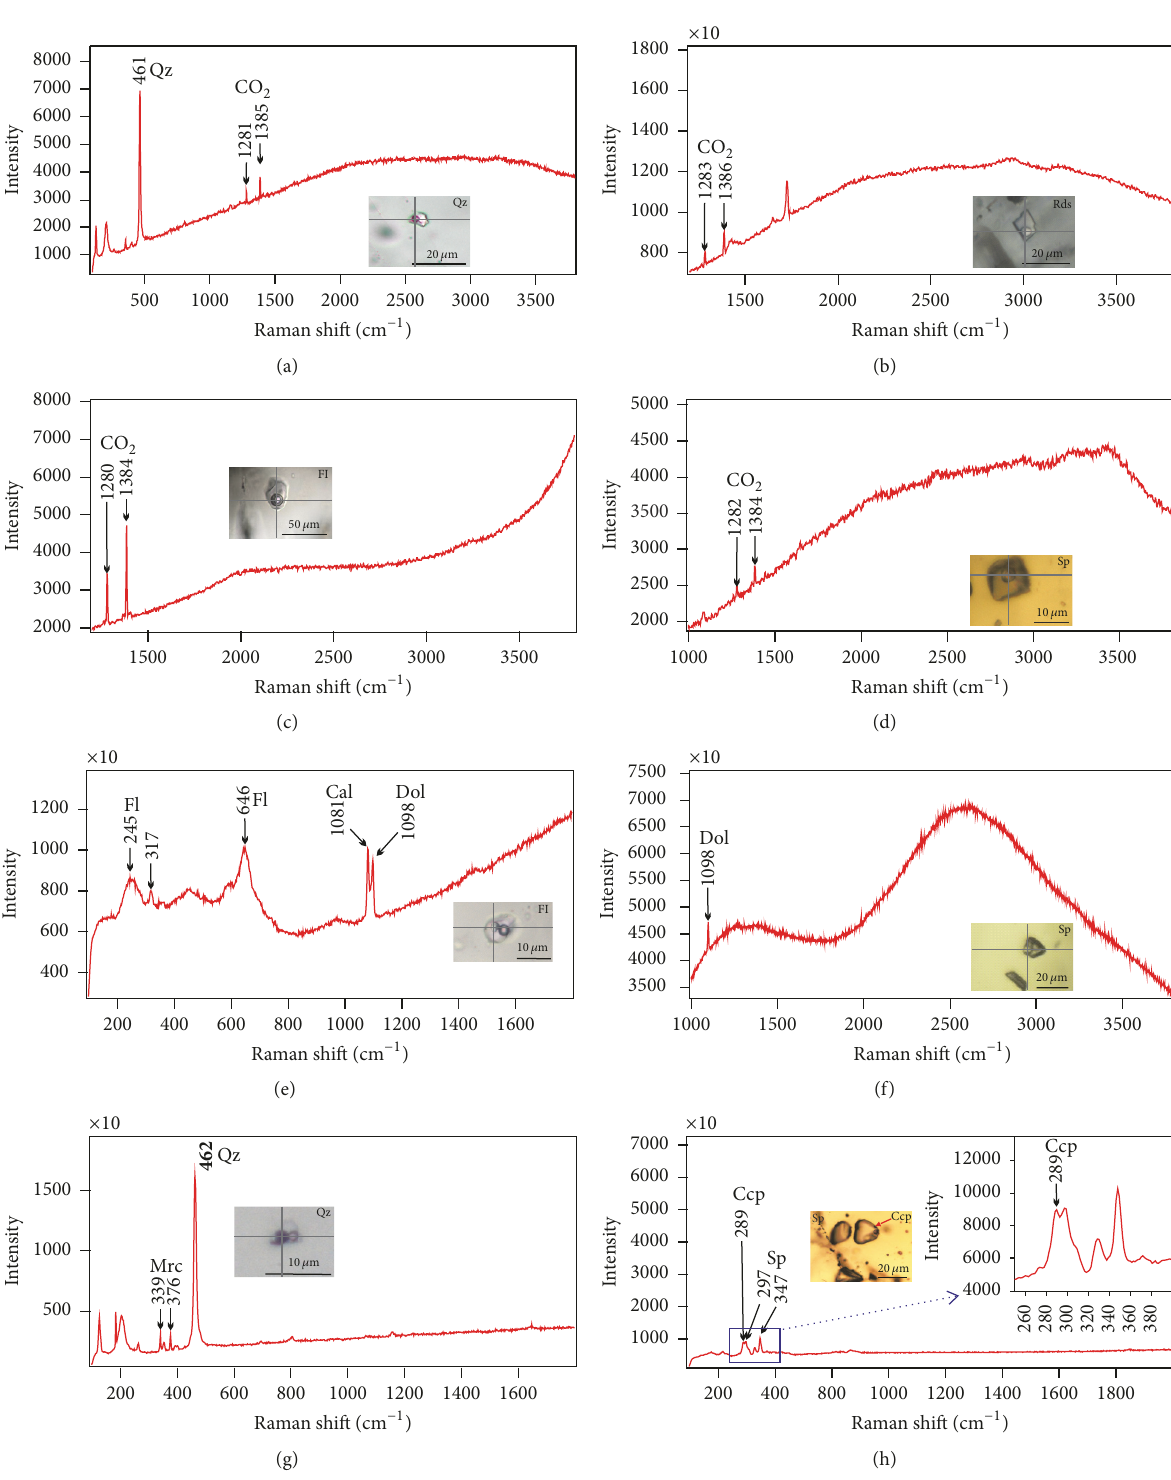
Figure 8: Laser Raman spectroscopy of different fluid inclusions (FIs). (a) CO 2 spectra of vapour in C-type FIs in the early stage quartz; (b) CO 2 spectra of vapour in a few W-type FIs in the main stage rhodochrosite; (c) CO 2 spectra of vapour in C-type FIs in the main stage fluorite; (d) CO 2 spectra of vapour in C-type FIs in the main stage sphalerite; (e) transparent daughter minerals in S-type FIs of fluorite being calcite and dolomite; (f) primary S-type FIs containing dolomite daughter mineral in sphalerite; (g) the opaque daughter mineral in the early stage quartz being marcasite; (h) the opaque daughter mineral in S-type FIs of the main stage sphalerite being chalcopyrite. Qz, quartz; Rds, rhodochrosite; Sp, sphalerite; Fl, fluorite; Cal, calcite; Dol, dolomite; Ccp, chalcopyrite; Mrc,